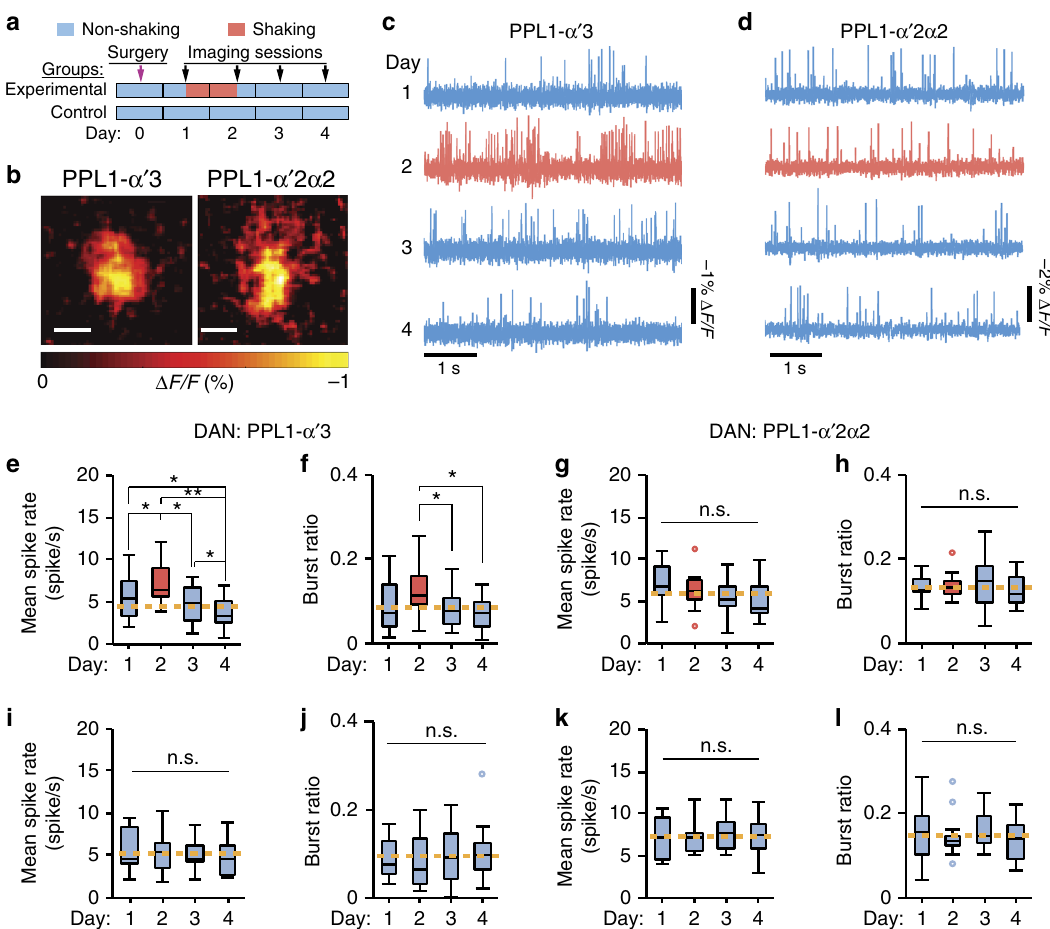
Fig. 7 Spontaneous spiking responds differently to mechanical stress in PPL1- α ‘ 3 versus PPL1- α ‘ 2 α 2 dopaminergic neurons. a Timeline: Laser surgery on Day 0, then daily voltage imaging for 4 days. From noon on Day 1, experimental but not control fl ies underwent 24 h of ongoing shaking. We performed three separate 10-s recordings per session per fl y. We averaged spiking metrics for each fl y across these three recordings; using the resulting mean values, we computed the box-and-whisker elements in e – l . b Spatial maps of mean fl uorescence response ( Δ F/F ) at the spike peak in axonal regions of a PPL1- α ’ 3 neuron in a MB304B-GAL4 > 20 × UAS-Ace2N-2AA-mNeon fl y (left) and a PPL1- α ’ 2 α 2 neuron in a MB058B-GAL4 > 20 × UAS-Ace2N-2AA-mNeon fl y (right), averaged over 140 and 113 spikes, respectively. Scale bars: 10 μ m. c Activity traces of a PPL1- α ’ 3 neuron, showing increased spiking after shaking (Day 2). d Activity traces of a PPL1- α ’ 2 α 2 neuron, showing normal spiking after shaking. e , f Spiking rates ( e ) and burst ratios ( f ) of PPL1- α ’ 3 neurons were elevated after shaking and then declined below baseline on Day 4 ( P = 4 × 10 − 4 in e , P = 0.01 in f ; n = 15 fl ies; Friedman ANOVA; * P < 0.05, ** P < 0.01 post-hoc Wilcoxon signed-rank test with Holm – Bonferroni correction). We computed the burst ratio as the number of spikes in a cell ’ s activity record occurring < 20 ms after the preceding spike, divided by the total number of spikes in the record. g , h Spiking rates ( g ) and burst ratios ( h ) of PPL1- α ’ 2 α 2 neurons were unaffected by shaking ( P = 0.05 in g , P = 0.9 in h ; n = 13 fl ies; Friedman ANOVA). i , j In control fl ies, spiking rates ( i ) and burst ratios ( j ) of PPL1- α ’ 3 neurons were stationary ( P = 0.9 in i , P = 0.5 in j ; n = 15 fl ies; Friedman ANOVA). k , l In control fl ies, spiking rates ( k ) and burst ratios ( l ) of PPL1- α ’ 2 α 2 neurons were stationary ( P = 0.8 in k , P = 0.3 in l ; n = 13 female fl ies; Friedman ANOVA). Yellow dashed lines: mean values averaged across all days without shaking. Box-and-whisker plots are formatted as in Fig.